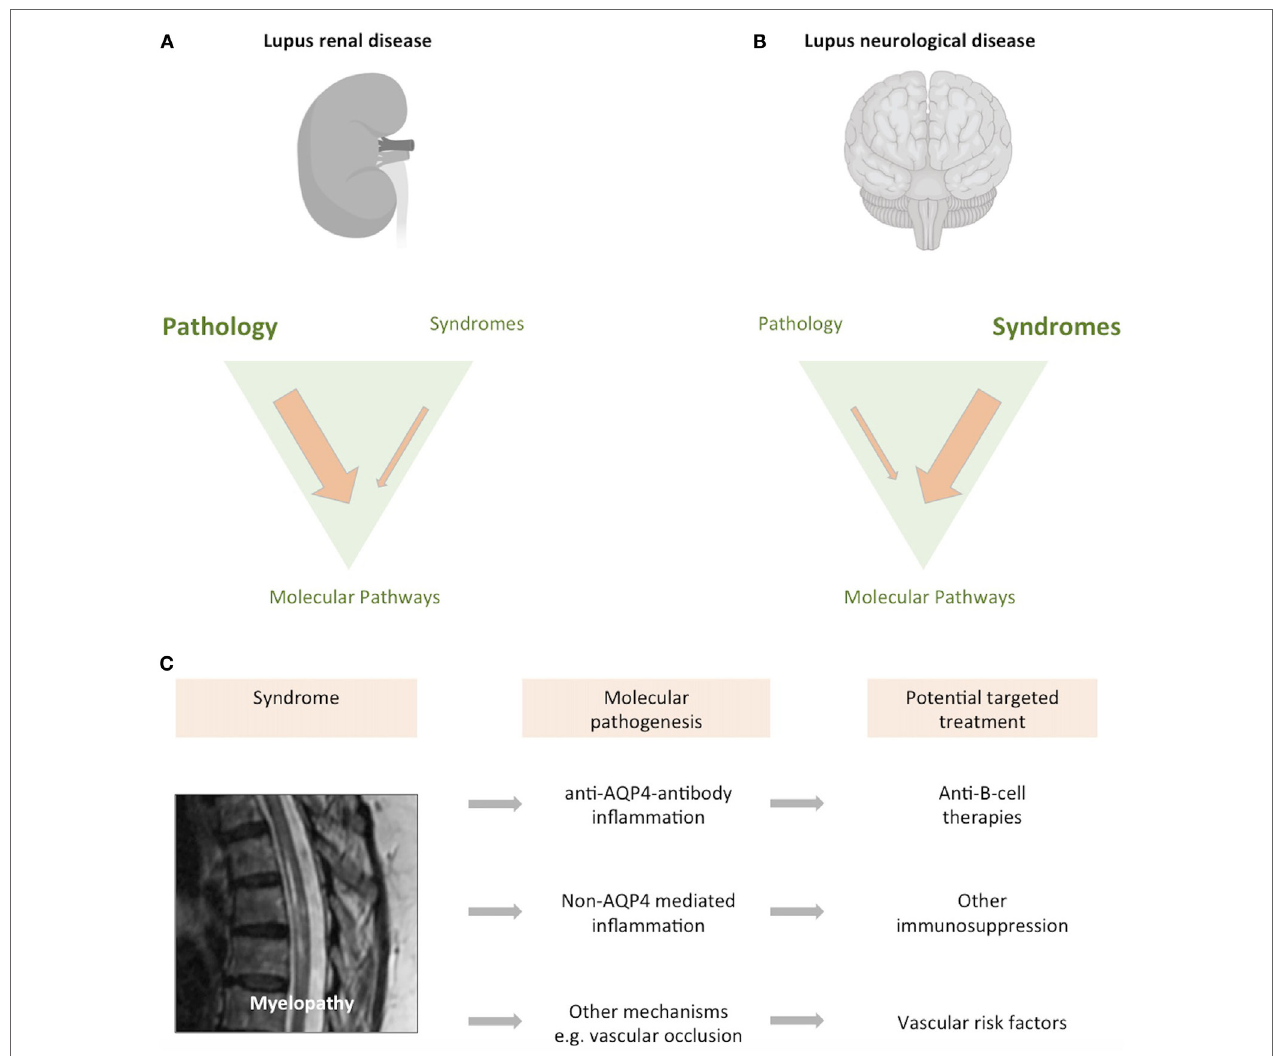
FigURe 2 | Classifying neurological disease in lupus. Both the brain and kidney can be severely affected in up to 10% of patients with lupus. (A) While lupus nephritis can present with different clinical syndromes, it is largely defined by a pathological classification of the renal biopsy. Image created with Biorender. (b) In contrast, neurological forms of lupus are usually classified according to neurological syndrome, and pathological material is rarely obtained. (C) We have an increasingly precise understanding of the syndrome previously described as “lupus myelopathy,” T2-weighted magnetic resonance imaging of long inflammatory lesion in person with lupus shown, with high signal from within the thoracic spinal cord. A proportion of such spinal cord presentations are driven by antibodies directed against aquaporin-4, a glial water channel (21). Other cases are caused by spinal cord inflammation without these antibodies, while some cases are associated with spinal cord ischemia (22, 23). Each of these causes may require consideration of differing therapeutic approaches. As such, what was previously considered a single disease entity can be caused by differing pathogenic mechanisms, with implications for treatment and clinical trial